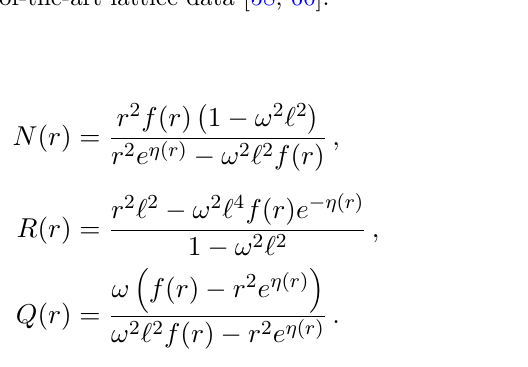
Figure 1 . The temperature dependence of entropy density s , pressure P , and trace anomaly I for the 2+1 flavor (left) and pure gluon (right) systems. Our holographic results (solid curves) [54, 55] quantitatively match the state-of-the-art lattice data [58,